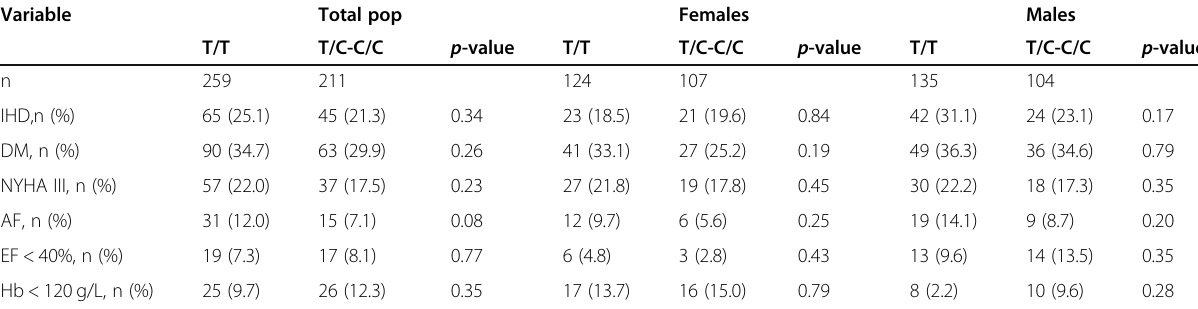
Table 9 Distribution of different well-known risk factors for cardiovascular mortality between the genotypes T/T and T/C or C/C amalgamated, of rs1478604 in the study population